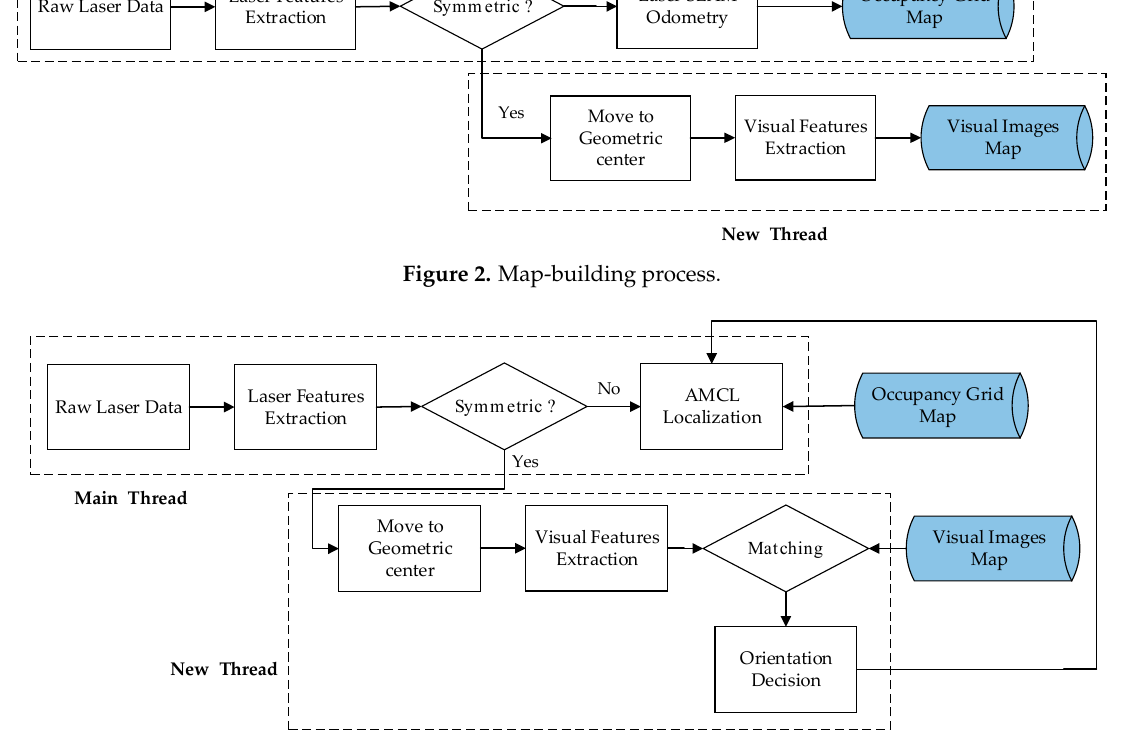
Figure 3. Localization process.